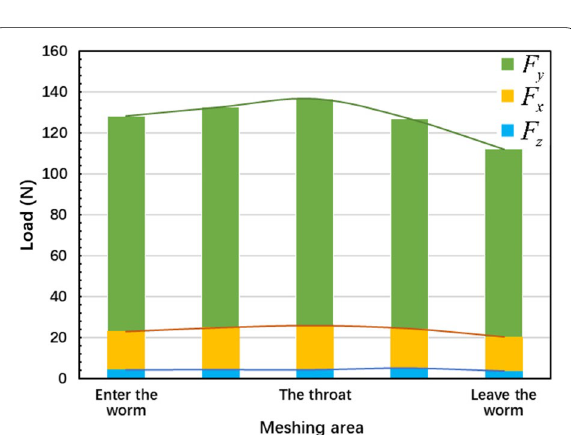
Figure 4 Distribution of load between